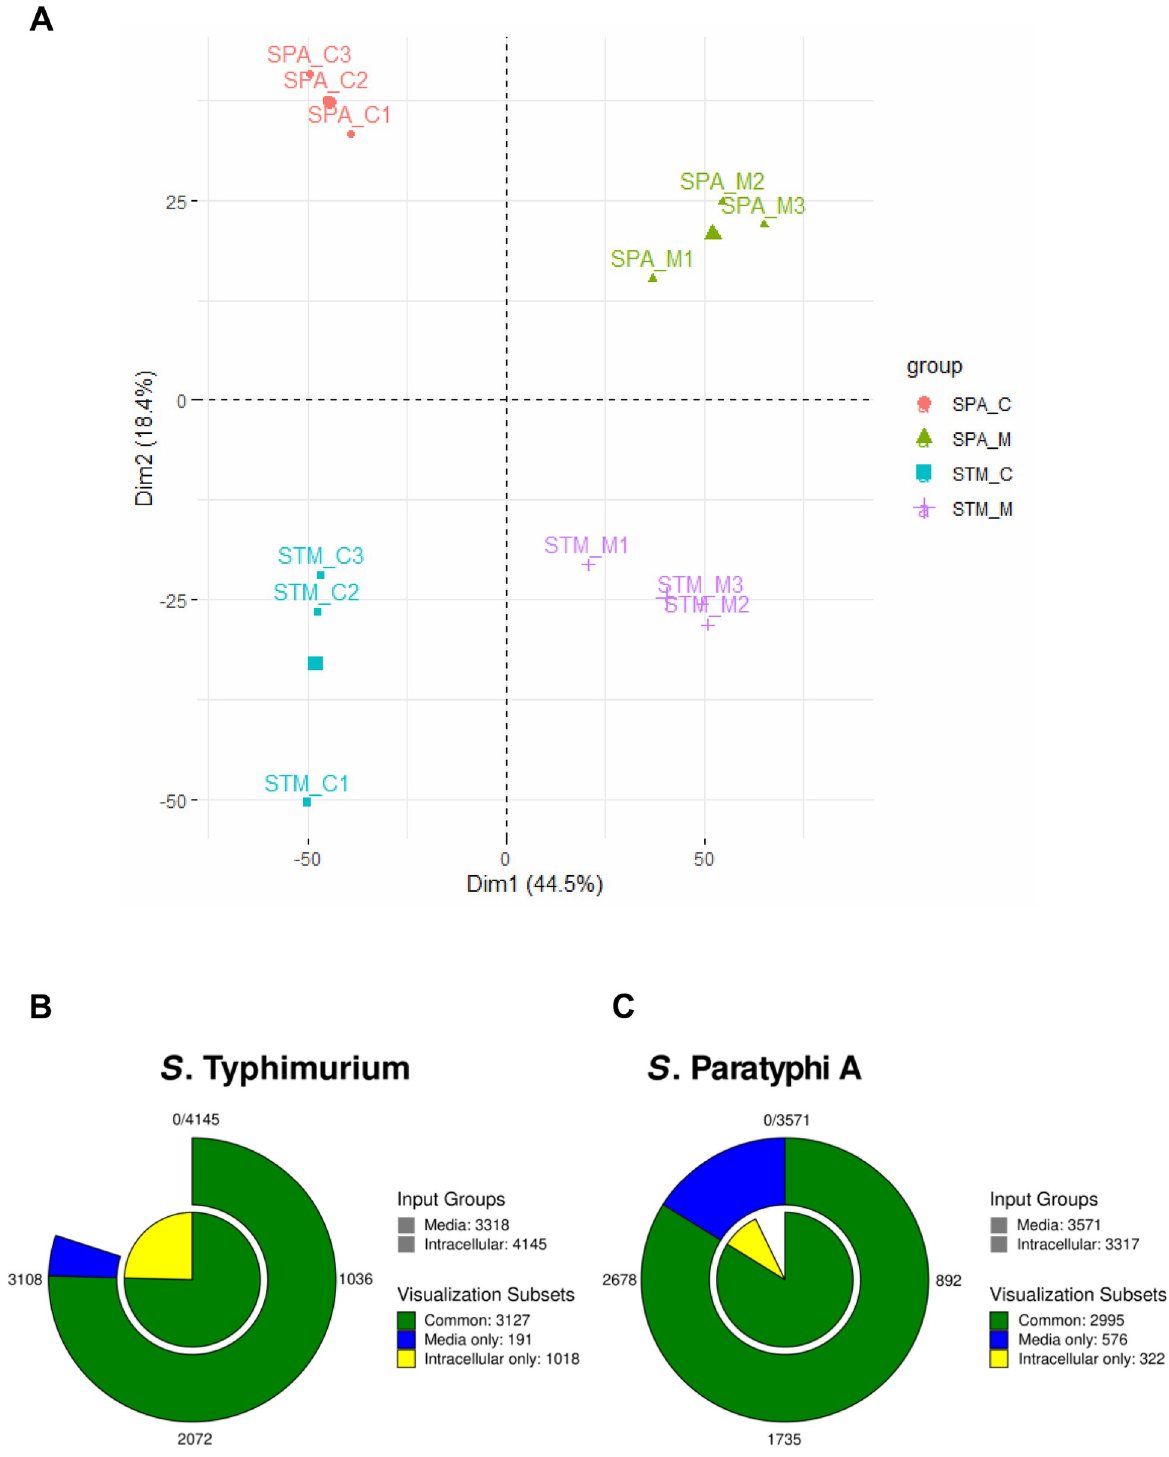
Fig 1. The number of STM and SPA genes expressed in LB medium and during intracellular growth. ( A ) Principal component analysis (PCA) of RNA-Seq data. The PCA was performed by using factomineR package on the normalized expression of 3851 shared genes of three independent SPA and STM cultures grown in LB medium (M1 to M3) and of three independent HeLa cell cultures (C1 to C3) infected with STM and SPA (as described in Materials and Methods). The percentages on each axis represent the percentages of variation explained by the principal components. Points that are closer together are more similar in gene expression patterns, and the barycenter of the triplicates used for each condition is shown